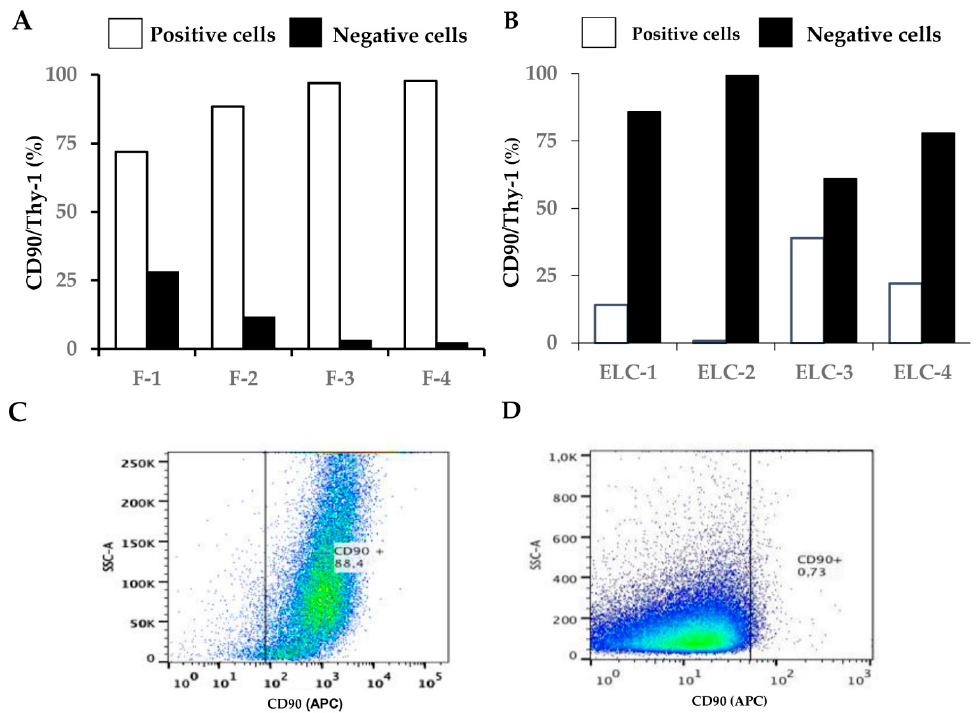
Figure 5. Thy-1 cell surface antigen (CD90) was downregulated in lung fibroblasts after undergoing mesenchymal–epi- thelial transition (MET) and exhibited the ELC phenotype. Cells were fixed, labeled with a Thy-1 cell surface antigen antibody (APC; Sc-59398, Santa Cruz Biotechnology; 1:200 dilution) and analyzed by cytofluorometry. The percentage of fibroblasts and the derived ELC cells expressing Thy-1 cell surface antigen were examined in four different cell lines ( A , B ). Four different cell lines were analyzed: two derived from ILD patients (lines F1/ELC-1; F-2/ELC-2), and two from brain dead patients (F-3/ELC-3; F3/ELC3). F: fibroblast; ELC: epithelial-like cell. C and D: Representative scatter dot - plot images of flow cytometry for CD90 in fibroblasts ( C ) and epithelial-like cell ( D ).